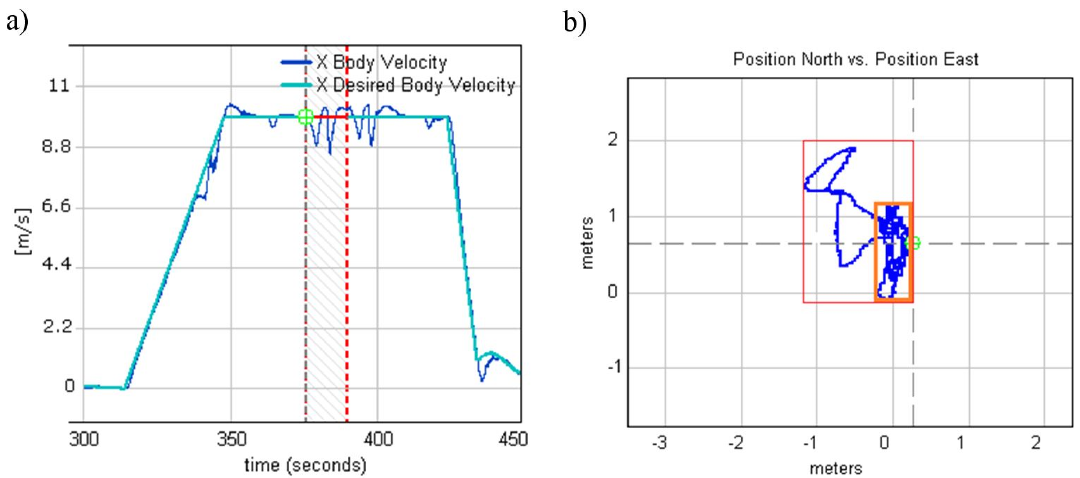
Figure 12. ( a ) X body velocity while approaching the 4th waypoint. ( b ) Relative position during Figure 12. a ) X body velocity while approaching the 4th waypoint. b ) Relative position during autonomous takeo ff autonomous takeoff.